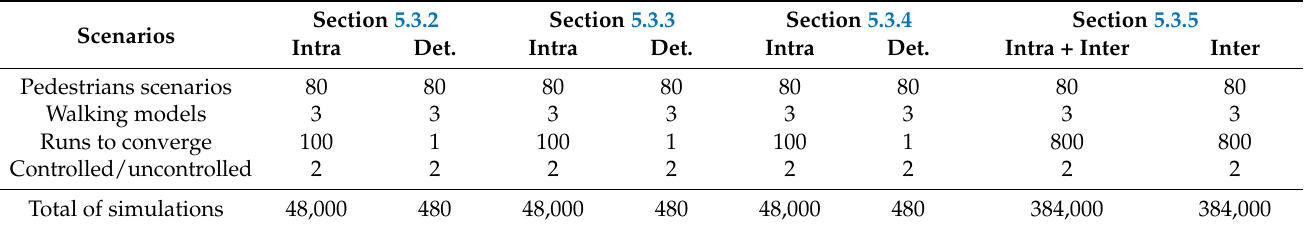
Table 3. Summary of load